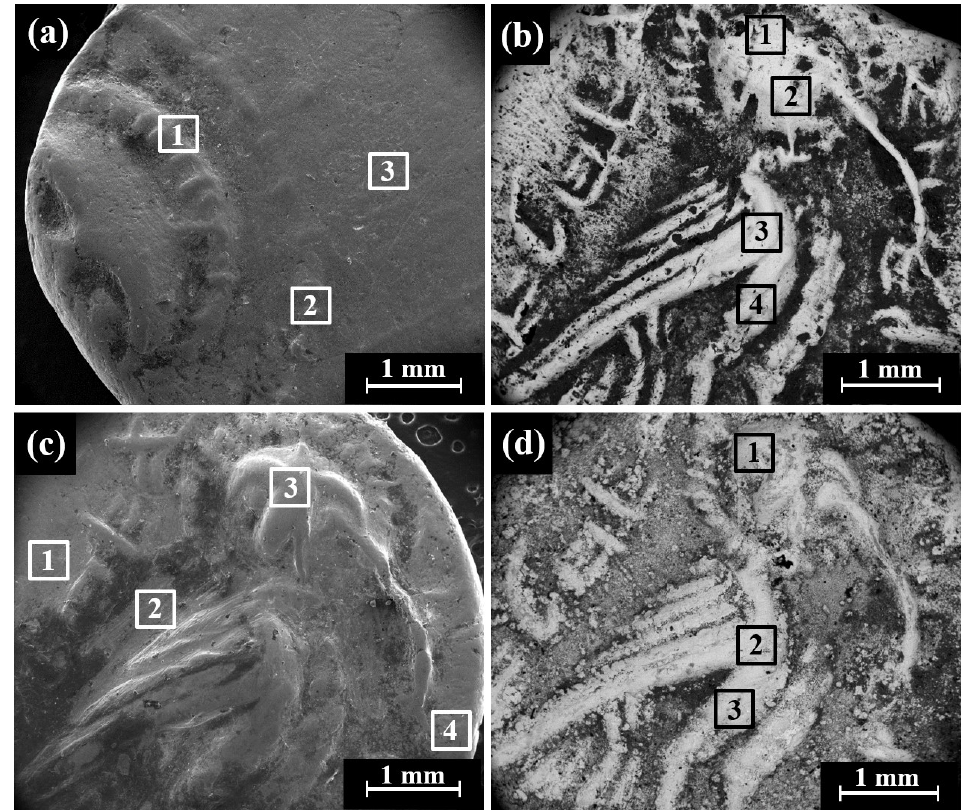
Figure 11. SEM images of the Trans-Jordan hoard coin Type 24 O1/R2: ( a ) coin Trans-Jordan 11 obverse side with a facing head (SE mode); ( b ) coin Trans-Jordan 11 reverse side with and owl (BSE mode); ( c ) coin Trans-Jordan 12 reverse (SE mode); and ( d ) coin Trans-Jordan 12 reverse (BSE mode). The areas 1 – 4 inside the squares were examined by EDS analysis.